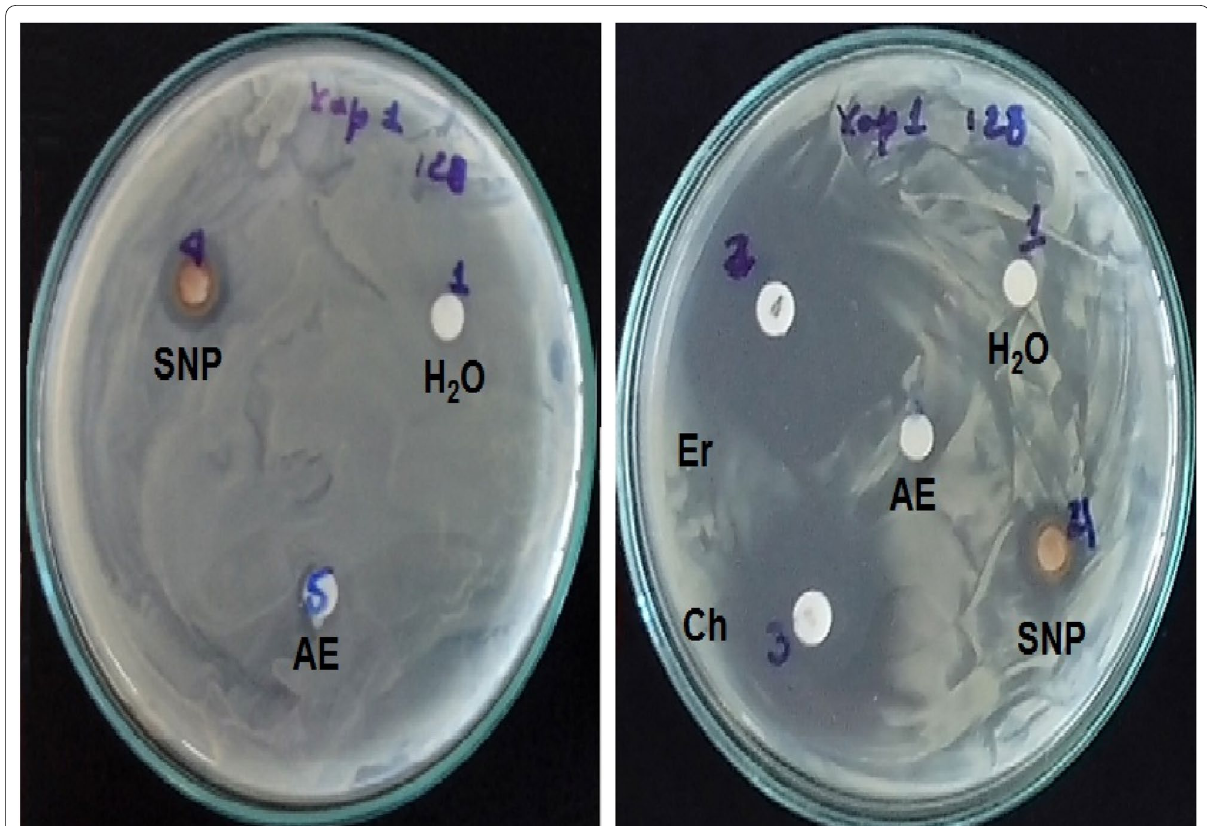
Fig. 7 Antibacterial activity of SNP from Leea coccinea leaves against Xanthomonas phaseoli pv phaseoli . SNP: silver nanoparticles; H 2 O: sterile water; Er: erythromycin; Ch: chloramphenicol; AE: aqueous extract of fresh leaves of L. coccinea